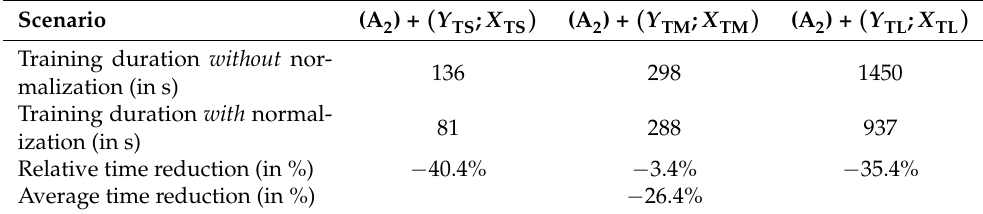
Table 5. Comparison of training duration and achievable time reduction of the training process by data set normalization for ANN Architecture (A 2 ) trained with small, medium and large training data set ( Y TS ; X TS ) , ( Y TM ; X TM ) or ( Y TL ; X TL )